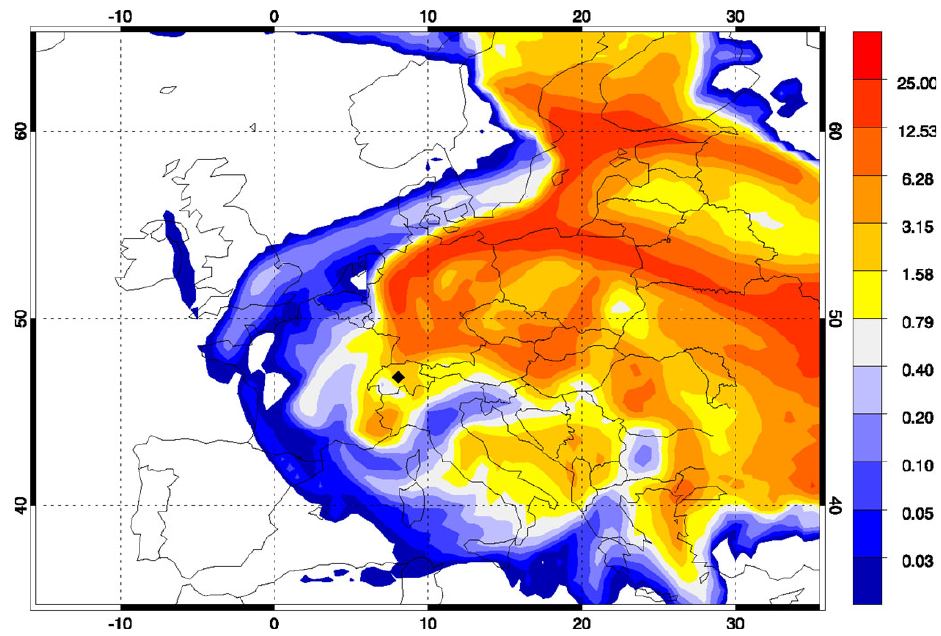
Fig. 7. Relative footprint map of trajectories associated with exceptionally high CO 2 concentrations (extreme event, case 1) recorded with the continuous measurements system at Jungfraujoch between 24 and 27 February 2005. Air masses originate from northeastern Europe. Colors correspond to the ratio of residence times over specific grid-cells relative to the average residence time of all trajectories, with yellow to red colors indicating above average and blue colors below average residence times. E.g. a value of 10 denotes that the selected trajectories had a 10 times higher probability to have passed over a particular grid cell than any arbitrary trajectory released from